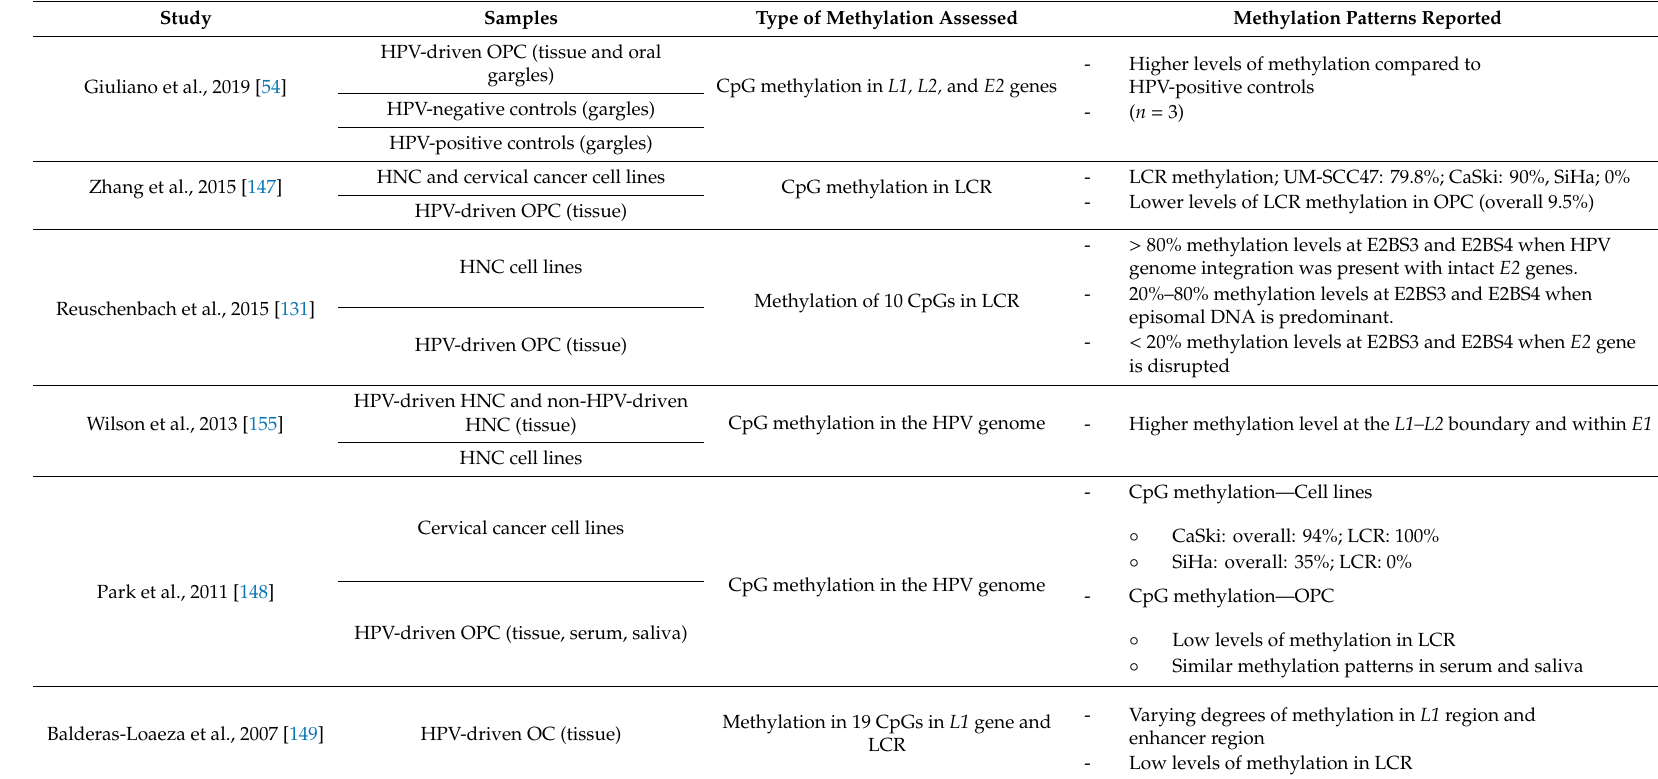
Table 2. HPV DNA methylation in HPV-driven